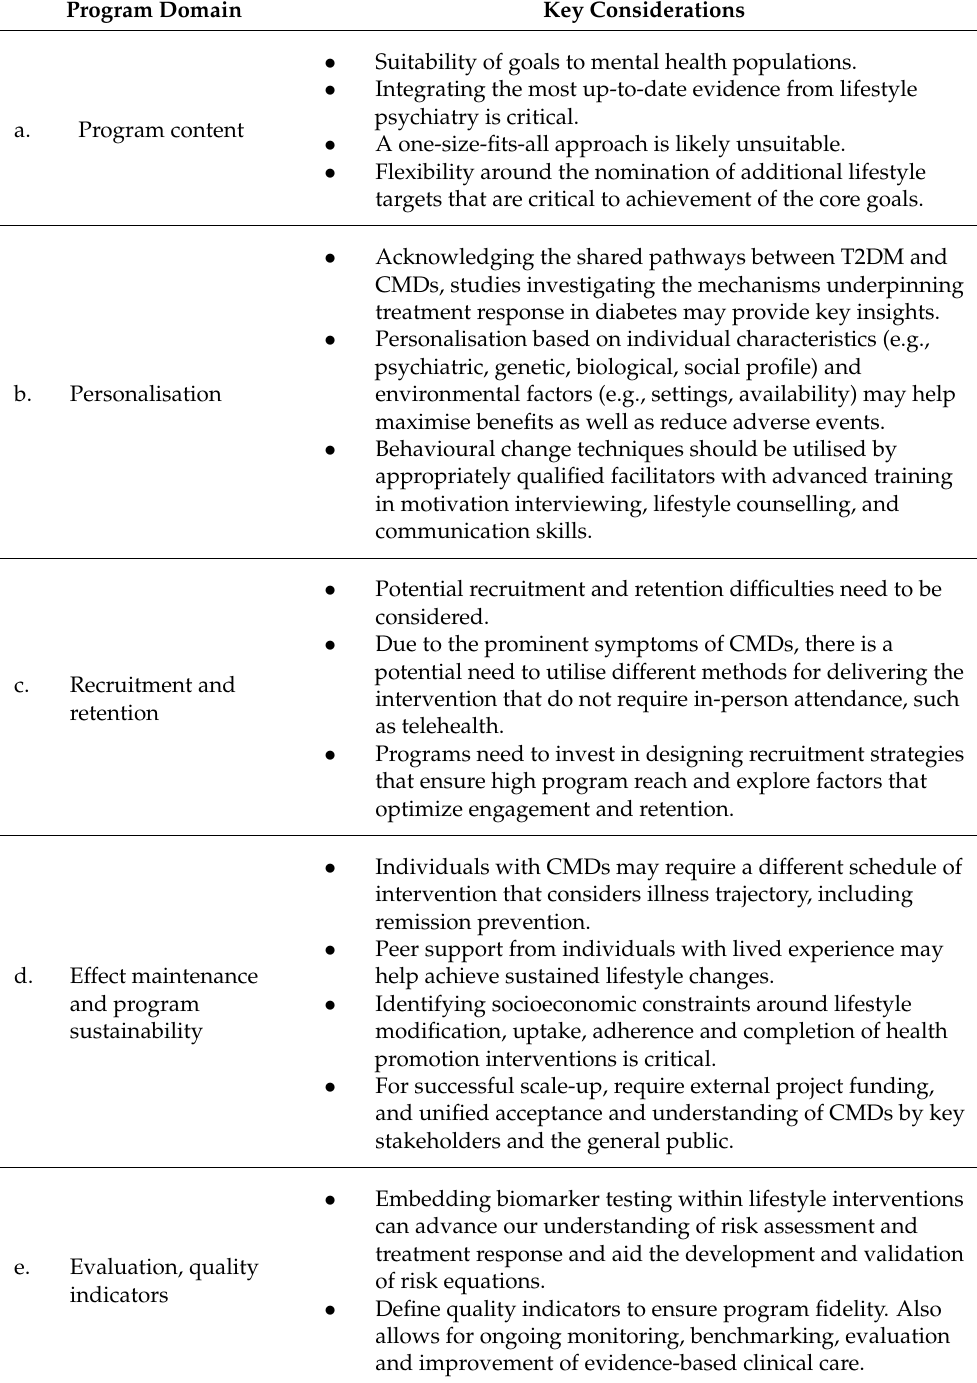
Refer to Table 1 for a summary of the key considerations for each program domain. Table 1. Summary of program domains and key considerations for adapting DPP style programs for the management of